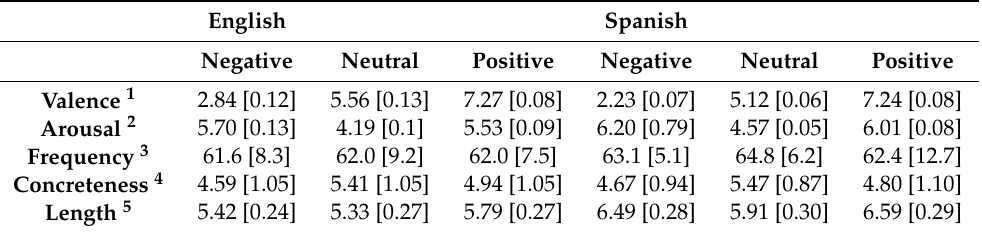
Table 2. Means for valence, arousal, concreteness, word length (number of letters) and word frequency for English and Spanish word stimuli. Square brackets represent SE.